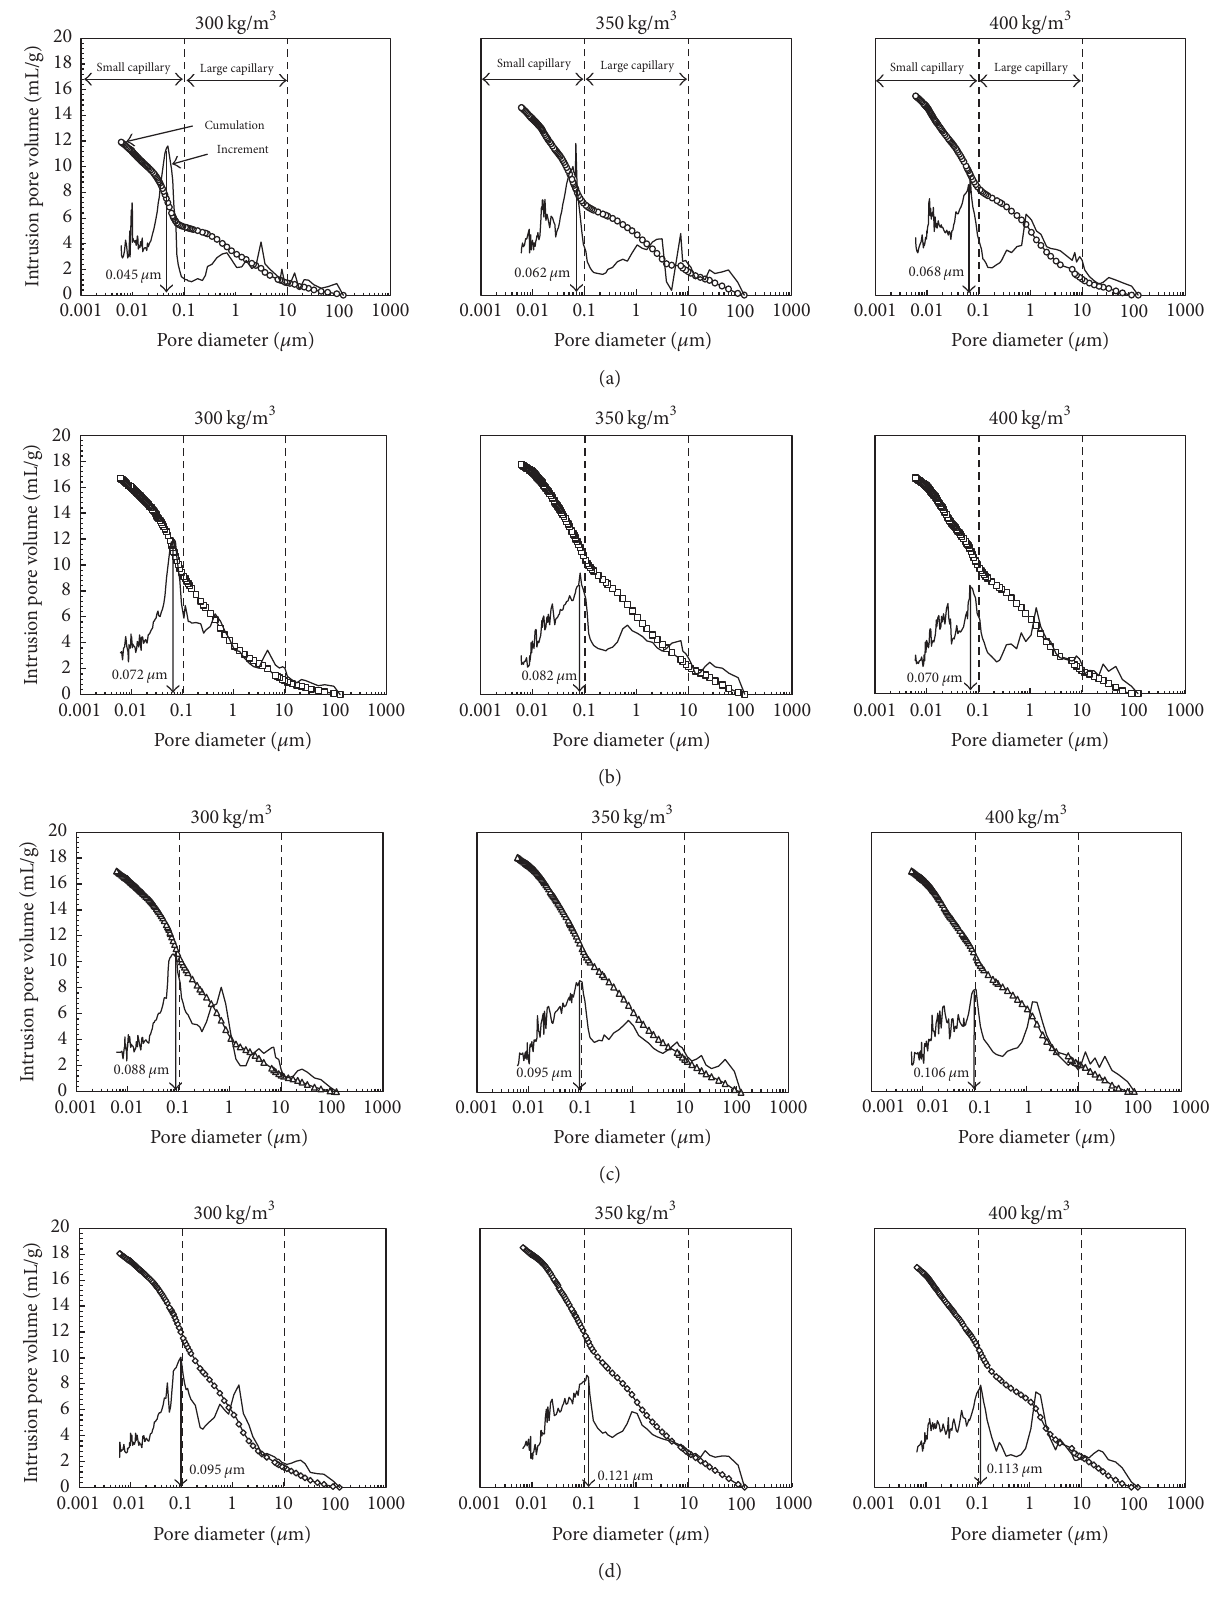
Figure 4: Pore-size distribution for 300, 350, and 400 kg/m 3 of cement content at (a) 0, (b) 60, (c) 120, and (d) 180